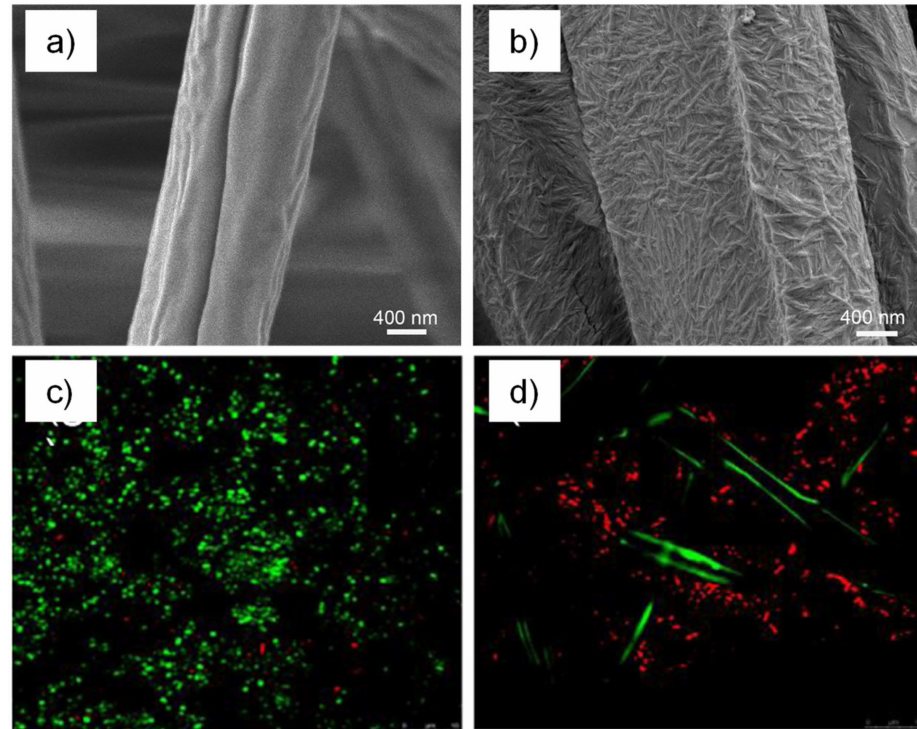
Figure 5. Scanning electron microscopy (SEM) images of electrospun cellulose acetate fibers alone ( a ) and coated with ChNCs ( b ). Fluorescent images of E. coli CECT 516 bacteria on surface cellulose acetate fibers alone ( c ) and coated with ChNCs ( d ) after 24 h of biofilm incubation and live/dead staining (green: live cells; red: dead cells). Adapted from Ref. [92]. Copyright 2016